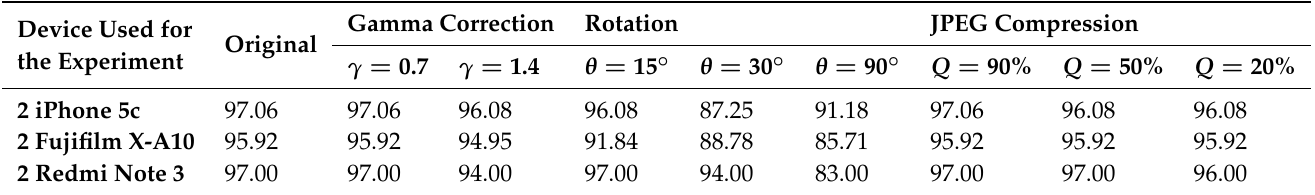
Table 7. Identification accuracy (%) of the proposed method under various image